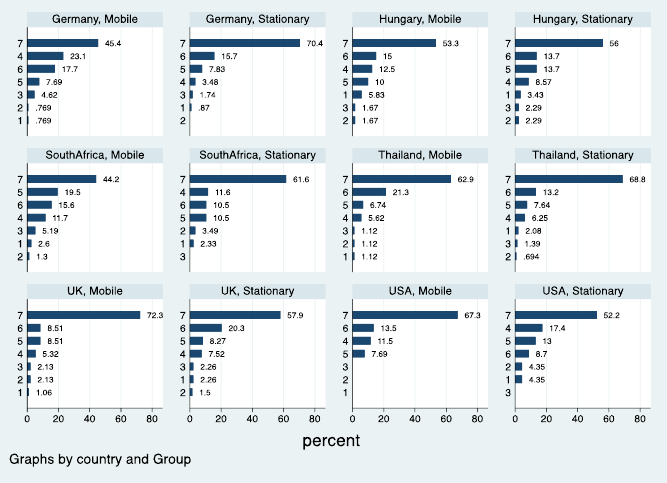
Figure 1: Survey responses in relative numbers to the statement “I would appreciate that probabilities of items in loot boxes are shown” (own